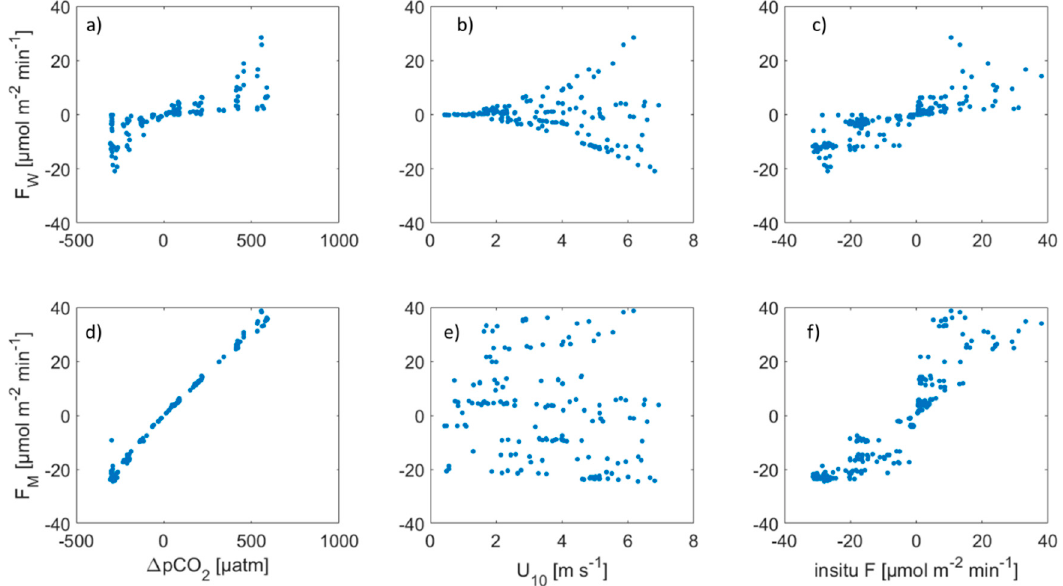
Figure 4. CO 2 flux calculated from the commonly used parameterization (F W ) ( a – c ) and from the parameterization with a nonzero intercept (F M ) ( d – f ) versus the ocean p CO 2 minus the atmospheric p CO 2 ( ∆ p CO 2 ) ( a , d ), versus wind speed normalized at 10 m ( b , e ), and versus the flux measured in situ from Sniffle during different cruises ( c, f ).